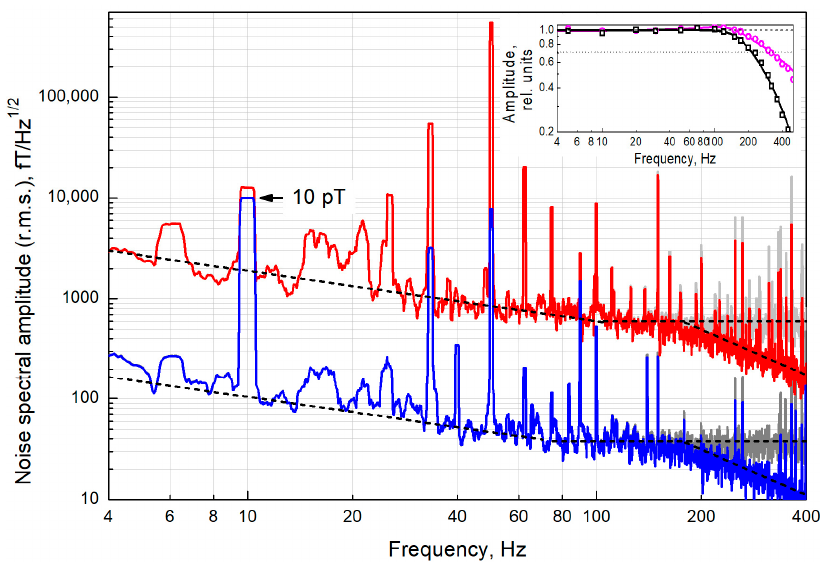
Figure 4. Noise spectrum of the magnetic resonance signal in cell C2 (red line), and the difference signal of magnetic resonances in cells C1 and C2 (blue line)—moving r.m.s. average in 1 Hz band. Gray lines are the spectra corrected for the frequency response of the sensor. The peak at a frequency of 10 Hz (marked with an arrow) is a calibration signal with an amplitude of 10 pT r.m.s. The peak at a frequency of 50 Hz is the interference from the main currents. The dashed lines are the noise floors of the signal in cell C2 and of the difference signal, respectively. Inset: the magenta line is the sensor's frequency response (cutoff frequency f 0 = 315 Hz), the black line is the sensor's frequency response, taking into account the time constant of the SR830 synchronous detector ( τ = 0.3 ms, 18 dB/octave).